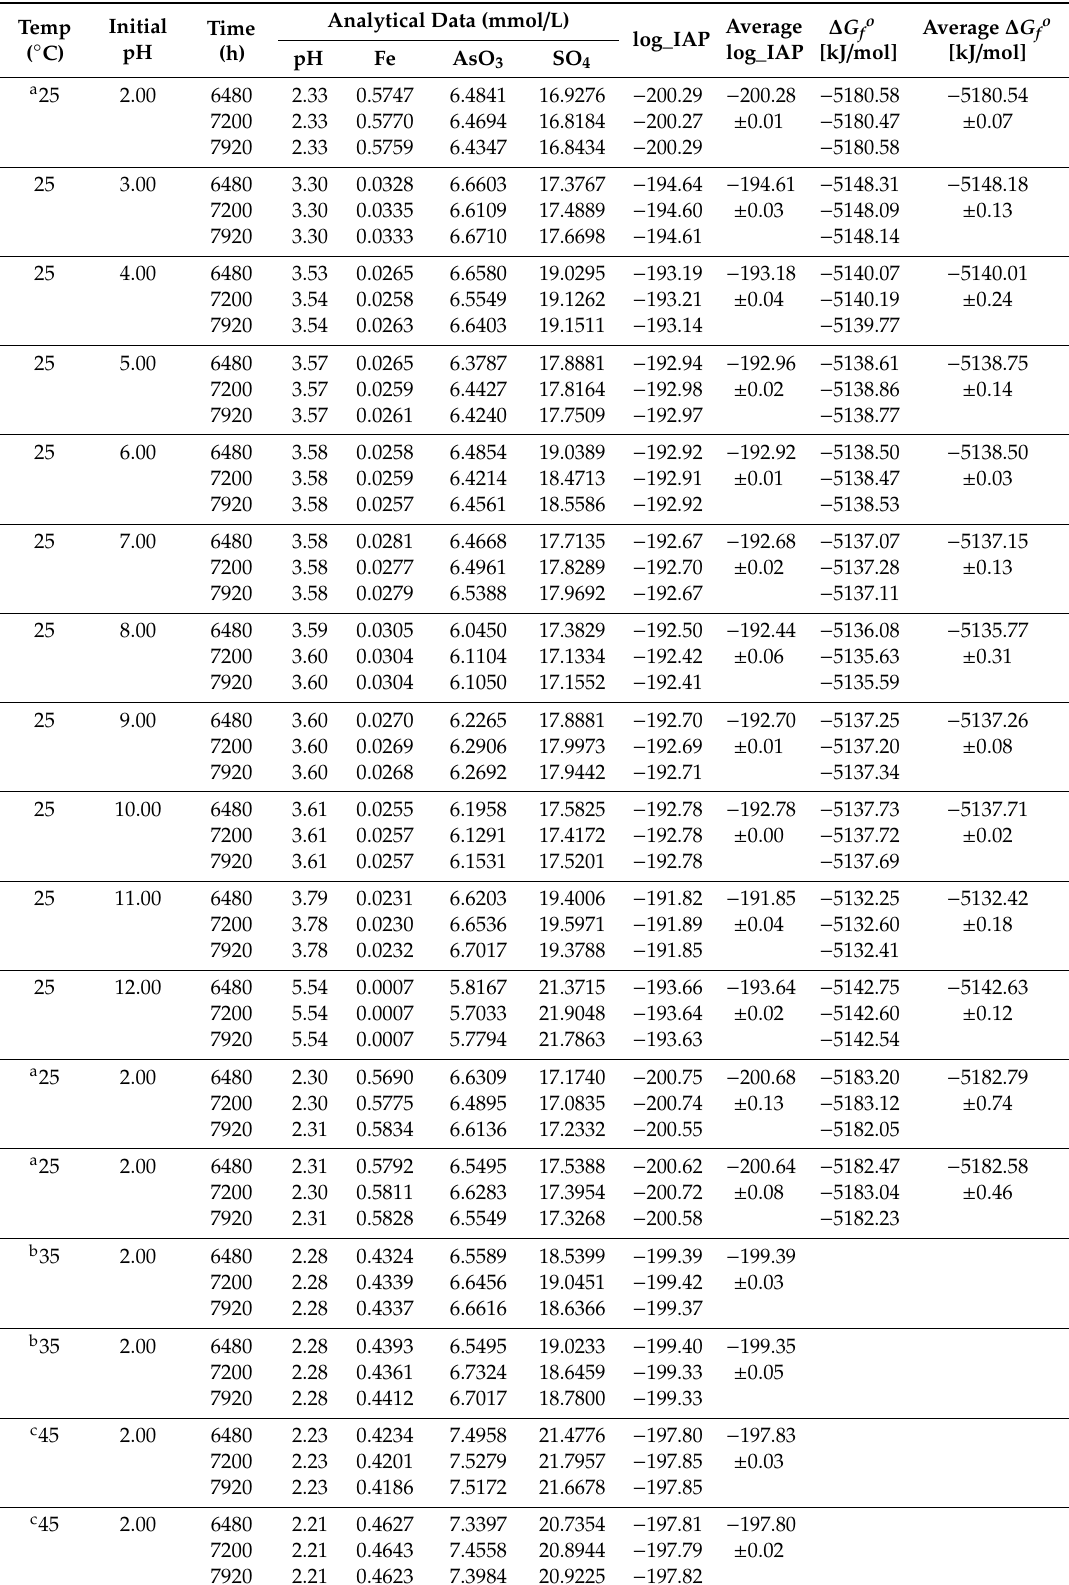
Table 2. Analytical data and solubility determination of the synthetical